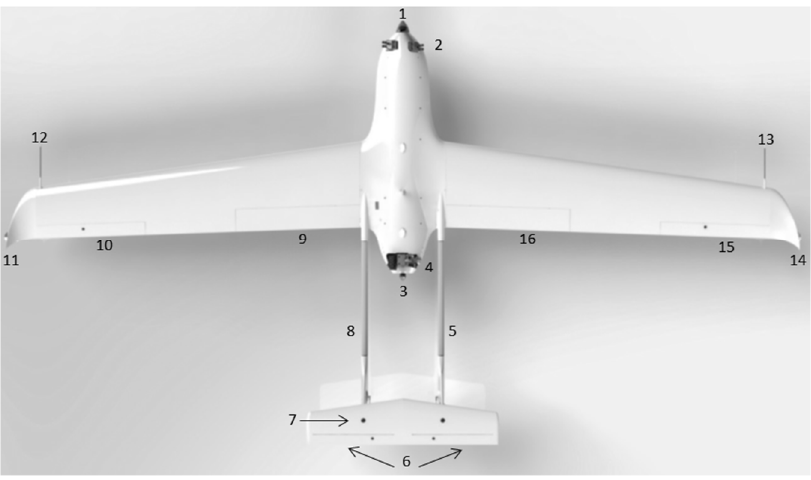
Figure 5. The aerodynamic and propulsion components of the UAV S45.